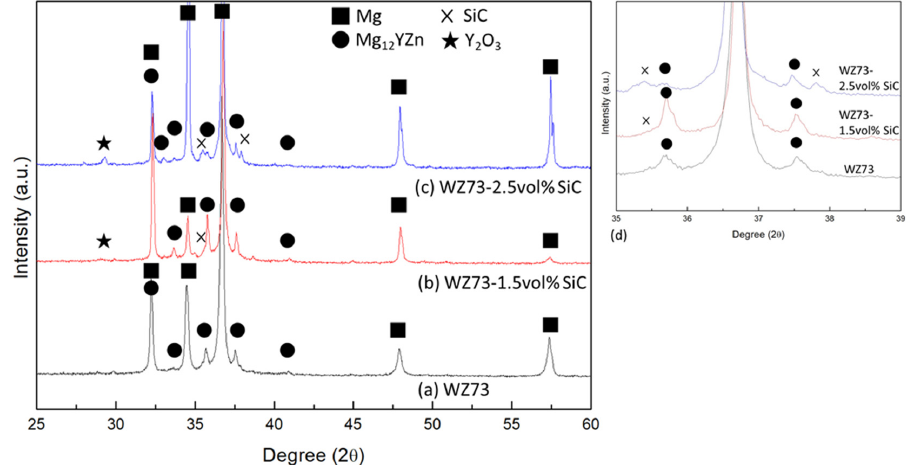
Figure 3. X-ray Diffraction (XRD) patterns of WZ73 and MMCs: ( a ) WZ73; ( b ) WZ73-1.5 vol% SiC; ( c ) WZ73-2.5 vol% SiC and ( d ) Zoom in of the peaks of SiC and Mg 12 YZn in a 2 theta range of 35° to 39°. Table 1. Chemical composition of selected areas in the WZ73 alloy and MMCs (at %).